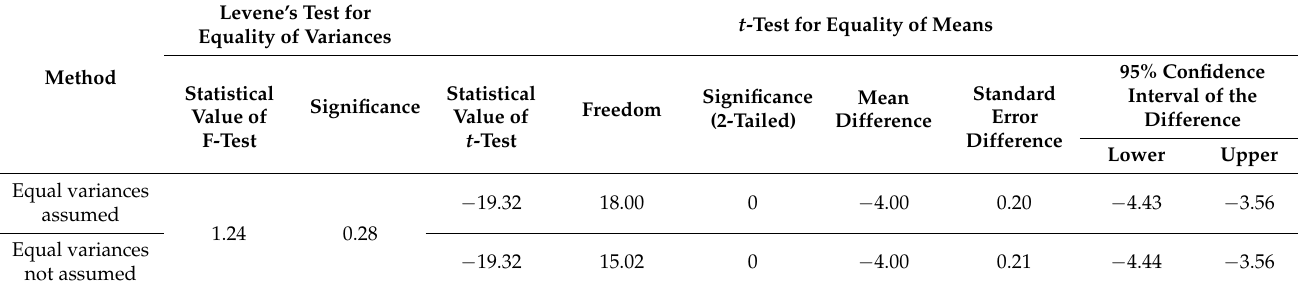
Table 3. t -Test result of color